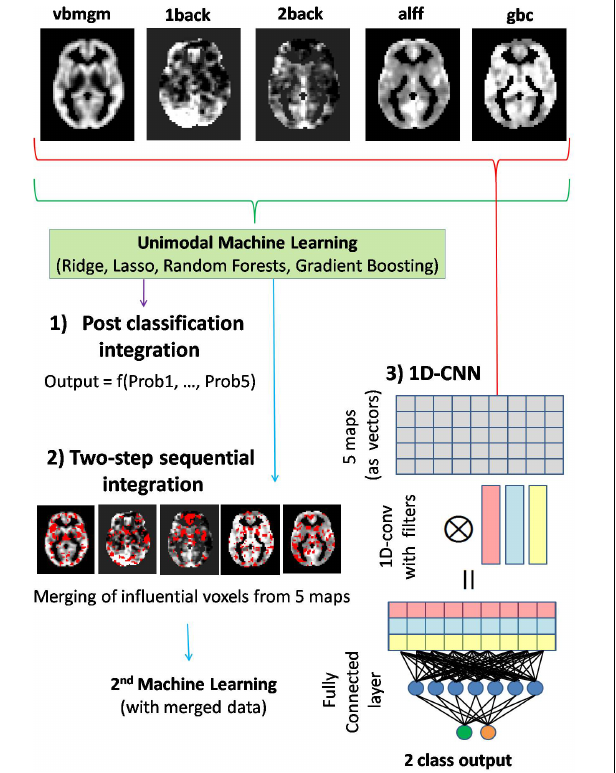
FIGURE 1 | Diagram showing the three multimodal integrative strategies starting from the five different brain maps pictured on top of the figure. (1) Post-classification integration based on functions of output probabilities delivered by unimodal classifiers. (2) Two-step sequential integration based on an initial unimodal classification used to select the most informative voxels from each map, and followed by a second classification only considering the values of these voxels as inputs of the algorithm. (3) Voxel-level multimodal integration with 1D-convolutional neural networks (1D-CNNs). In this last approach, one-dimensional convolutions are applied across brain maps generating new maps that are combinations of the original ones. This is followed by a second fully connected layer linked to the two-node output layer (patient–control